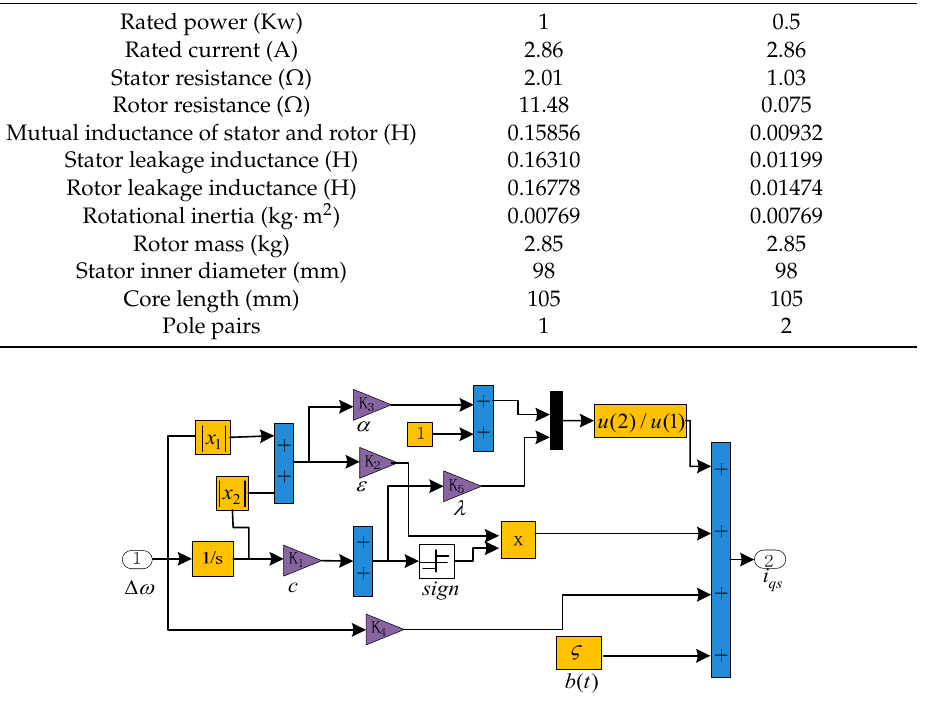
Figure 3. The proposed ASMC.